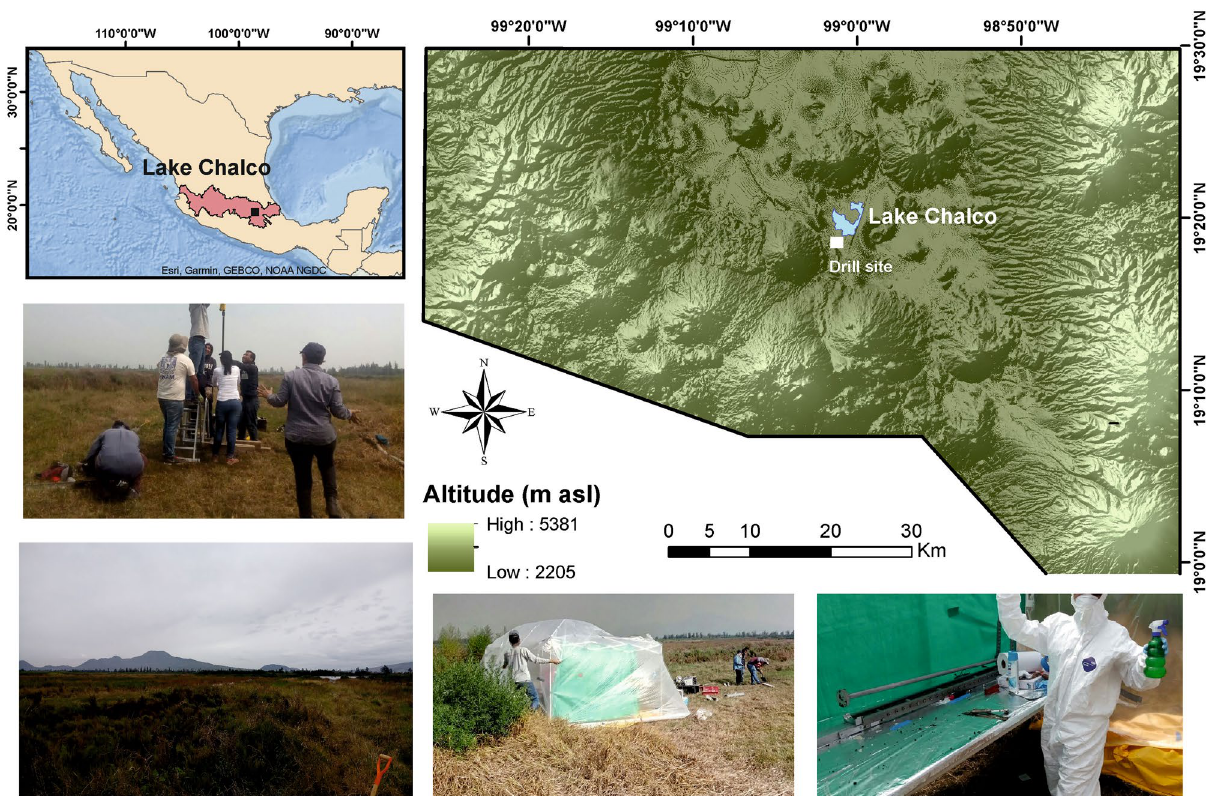
Figure 1. (Top left) Map of Mexico showing the Trans-Mexican Volcanic Belt (TMVB, red area) and the location of Lake Chalco (black square), southeast of Mexico City, and (Top right) the drill site (white square). Images illustrate the field laboratory and drill operations. The map was created with ArcGIS Desktop 10.6.1 (URL: http:// www. esri. com) and CorelDRAW 2020 version